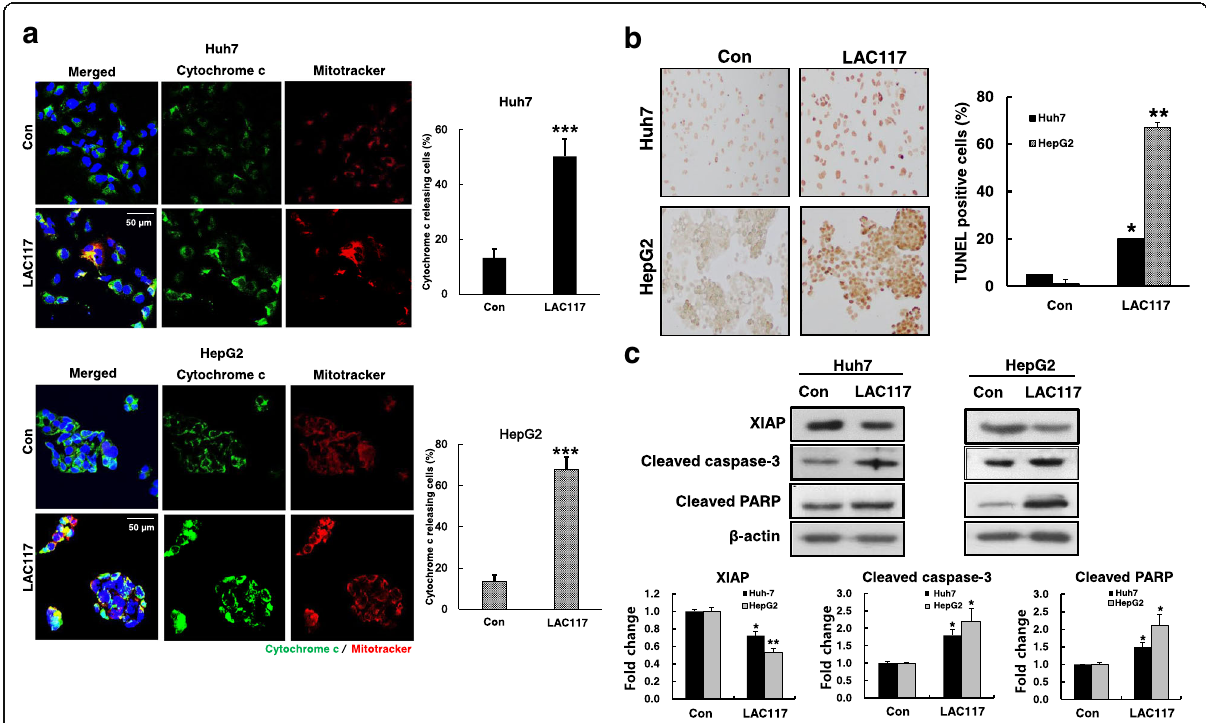
Fig. 3 Effect of LAC117 on mitochondria-mediated apoptosis in HCC cells. a Huh7 and HepG2 cells were treated with LAC117 (100 μ g/mL) for 6 h, and then stained with Mitotracker (green) and cytochrome c (red). Localization of cytochrome c in the cytosol was analyzed by confocal fluorescent microscopy at ×200 magnification. b Before performing TUNEL assay, HepG2 and Huh7 cells were treated with LAC117 (100 μ g/mL) for 24 h. The results were observed by microscopy at ×200 magnification. c The expression of cleaved caspase-3, PARP, and XIAP was determined by Western blotting in cells treated with LAC117 (100 μ g/mL) for 24 h. Data are represented as mean±SEM of triplicates (* P <0.05 and ** P <0.01 vs